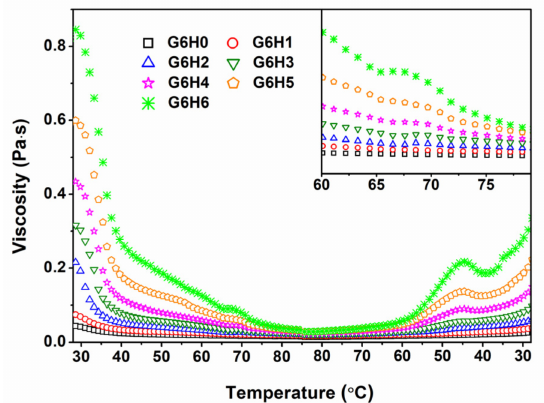
Figure 3. Effect of temperature on the viscosity of GA/HPMC mixed systems.